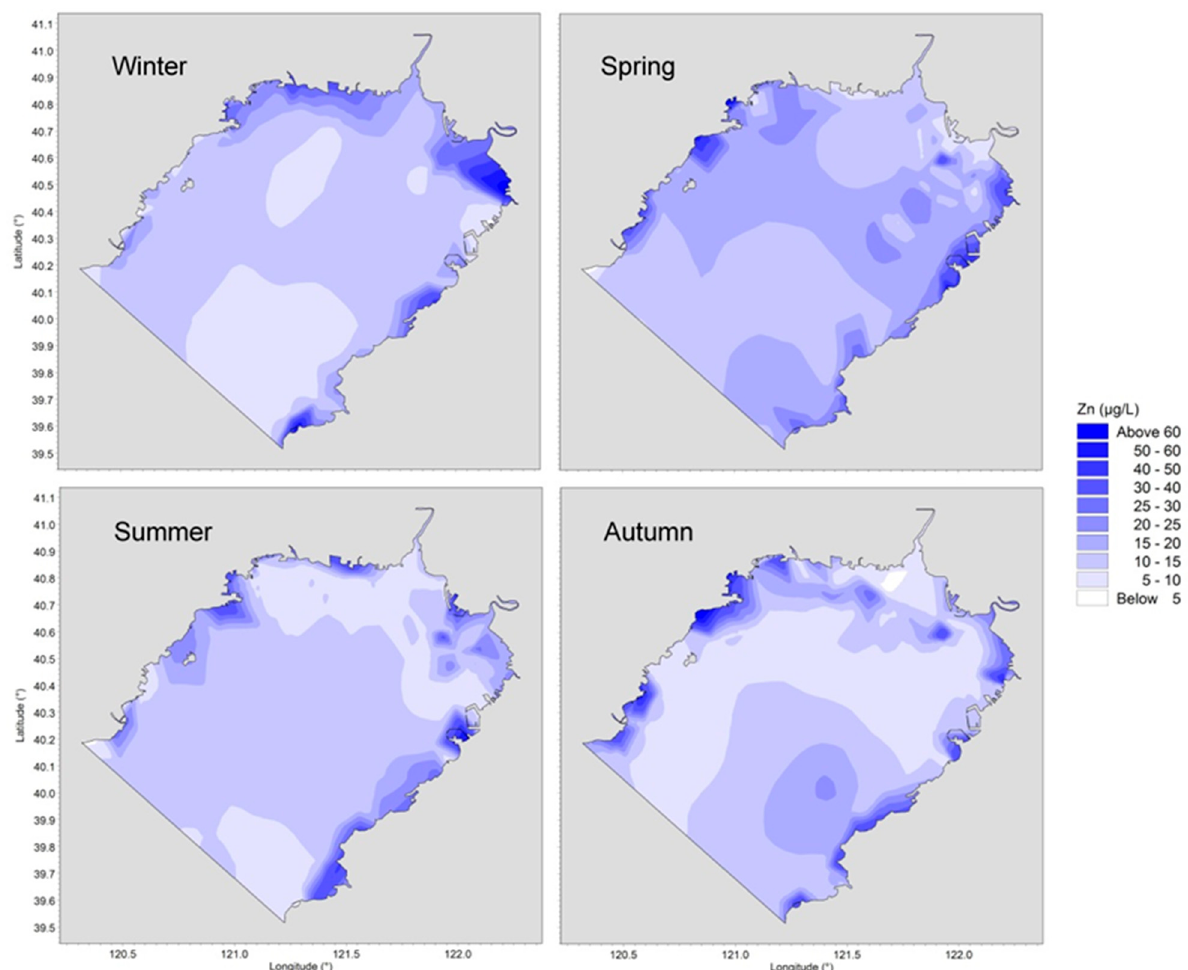
Figure 7. Horizontal distributions of dissolved Zn in Liaodong Bay from February 2020 to October 2020.